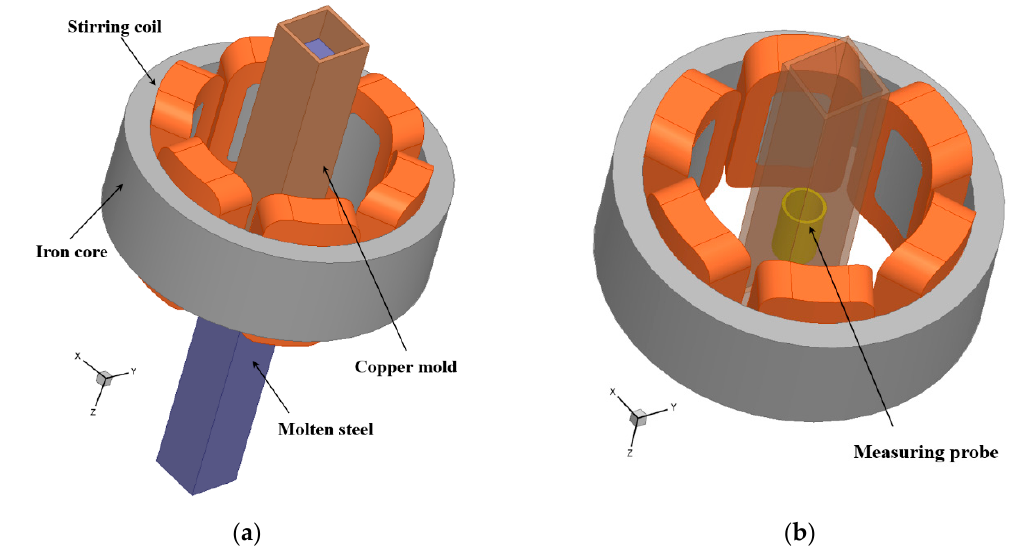
Figure 1. Schematic diagram of the model: ( a ) with strand; ( b ) with probe.